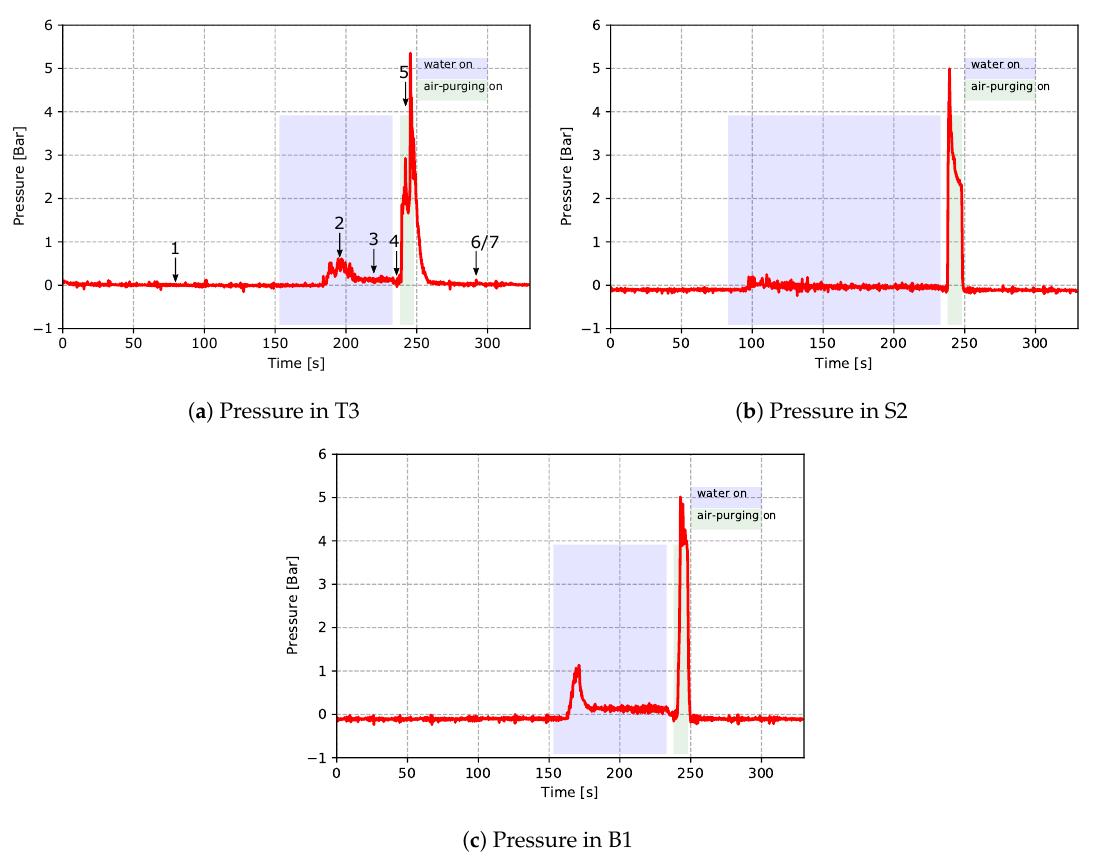
Figure 13. Pressure measured within cooling channels—data from cycle 12 for the production process